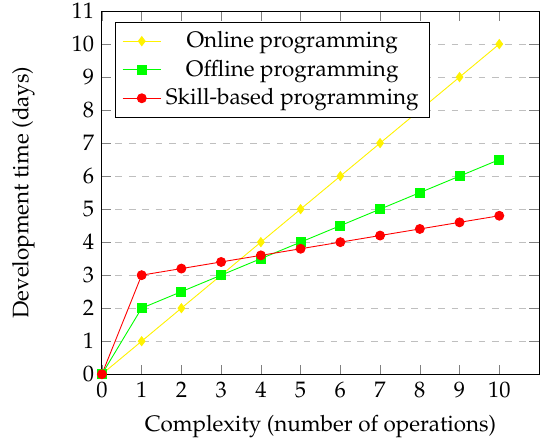
Figure 14. Comparison of the process development time according to its complexity.